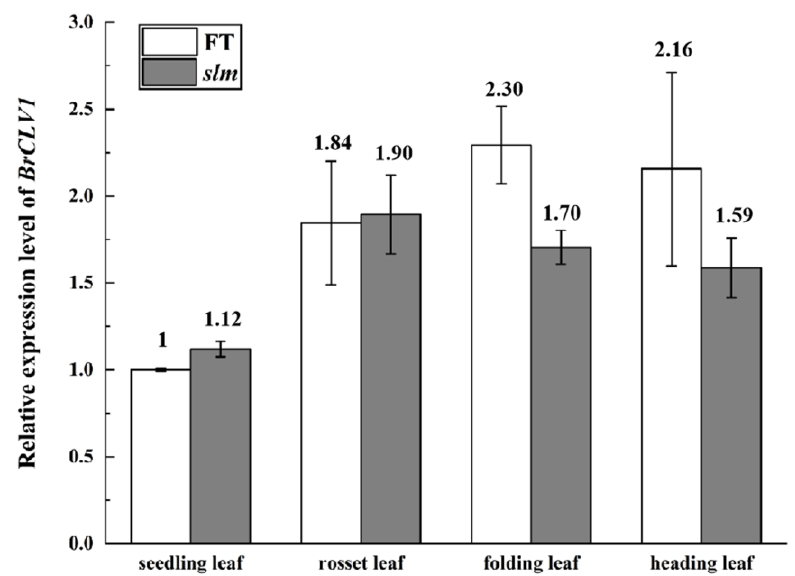
Figure 5. Expression of BrCLV1 in leaves during diversified stages. Expression of BrCLV1 in seedling leaf, rosette leaf, folding stage, heading leaf of FT and slm was measured by qRT-PCR.